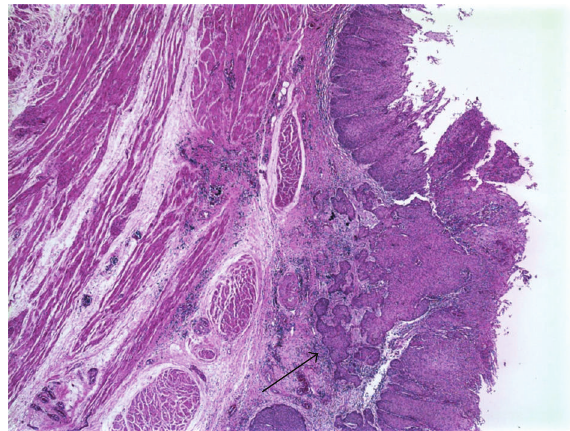
Figure 2: At autopsy, the bladder mucosa was found to have di ff use squamous metaplasia. A microscopic image demonstrates a region of invasive squamous cell carcinoma ( arrow ) that extended into the muscularis propria.